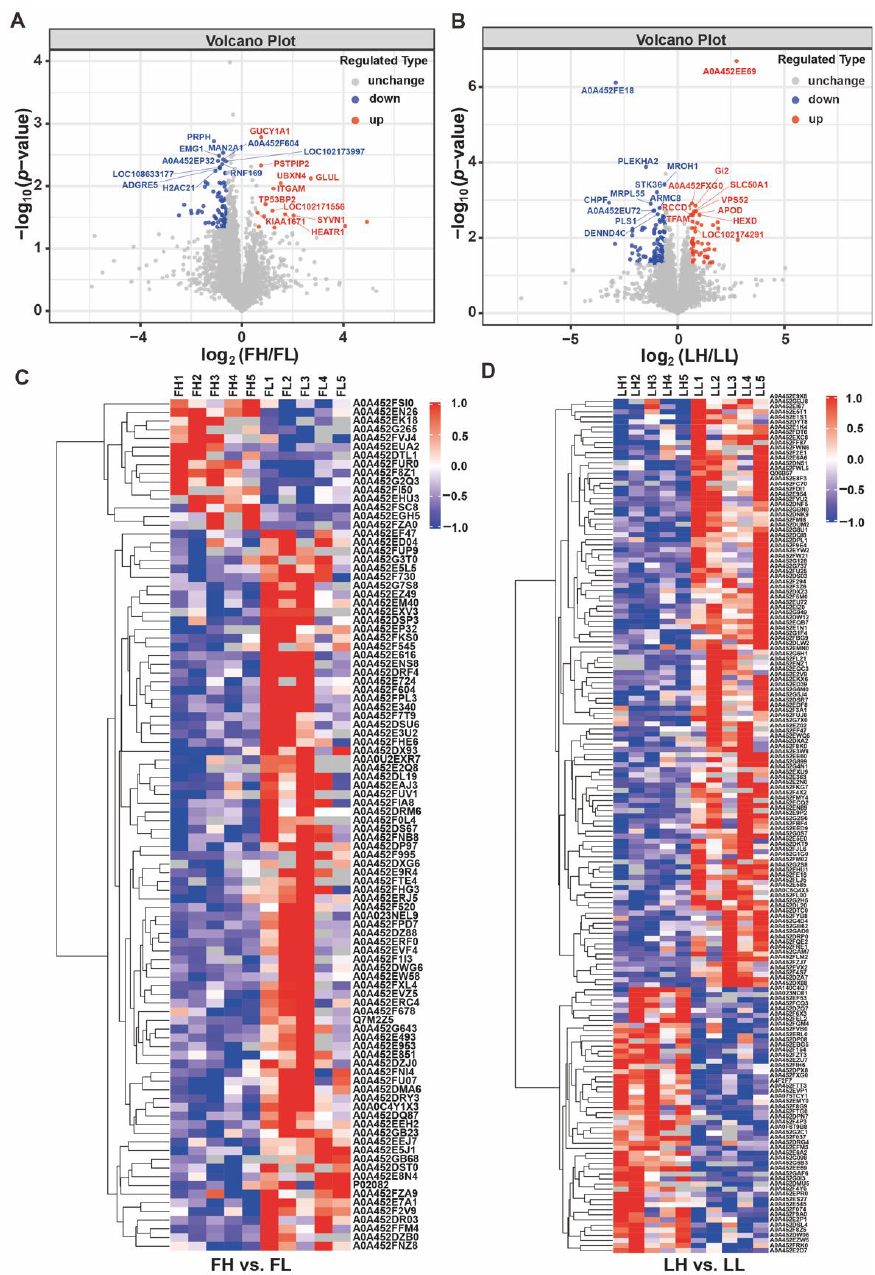
Figure 3. Differential abundant proteins (DAPs) screening and clustering analysis. Volcano plot of DAPs in the two comparison groups of FH vs. FL ( A ) and LH vs. LL ( B ). The X-axis represents the fold change in protein expression of different comparison groups. The Y axis represents the statistical significance of proteins. The blue dots represent the proteins that were not significantly downregulated, the red dots represent proteins that were significantly upregulated, and the gray dots represent proteins that were not significantly different. Cluster analysis of DAPs in the group of FH vs. FL ( C ) and LH vs. LL ( D ). The hierarchical clustering results are represented as a tree heat map, with the ordinate representing significantly differentially abundant proteins and the abscissa representing sample information. Red represents significantly upregulated proteins, blue represents significantly downregulated proteins, and gray represents no quantitative information for proteins.